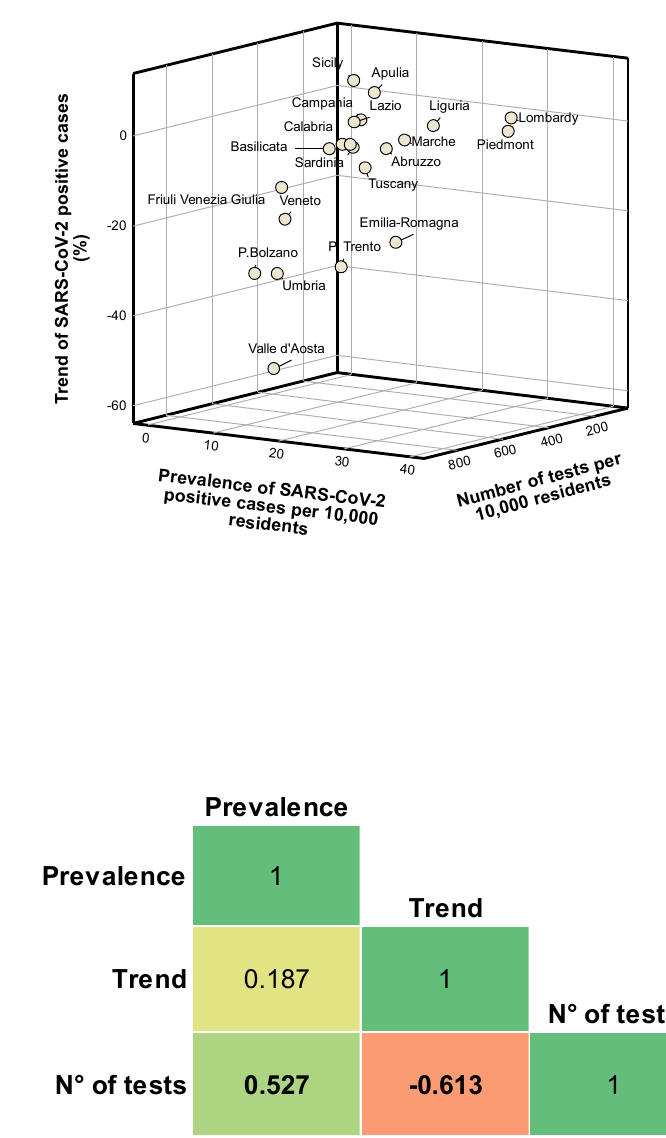
Figure 1. Description and correlation of regional indicators: ( A ) the distribution of Italian regions by prevalence of SARS-CoV-2 positive cases, their trend, and the number of tests performed; and ( B ) the correlations between the prevalence of SARS-CoV-2 positive cases, their trend, and the number of tests performed; the results are reported as Spearman’s correlation coefficient from −1 (in red) to 1 (in green).